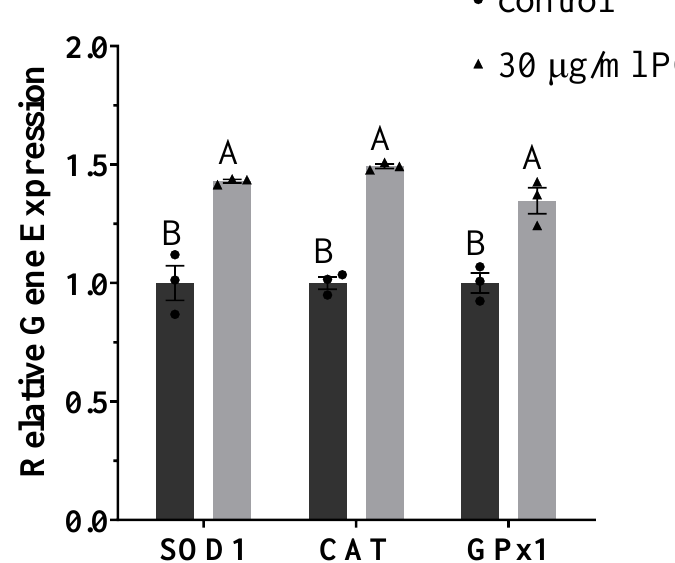
control group ( p < 0.05).